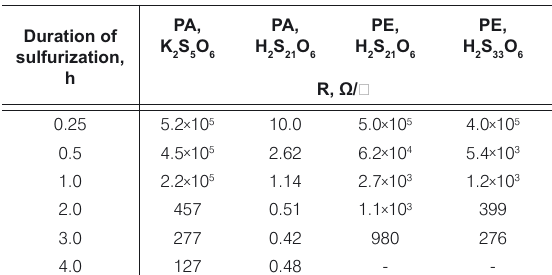
in a solution of K H S O ) and then – in Cu(II/I) salt solution 2 33 6